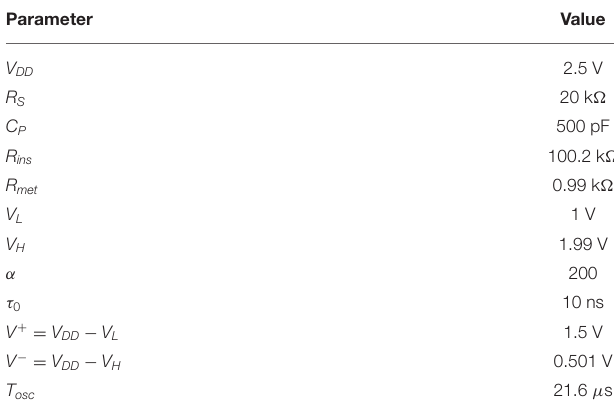
TABLE 1 | List of parameters used for simulations in this work.